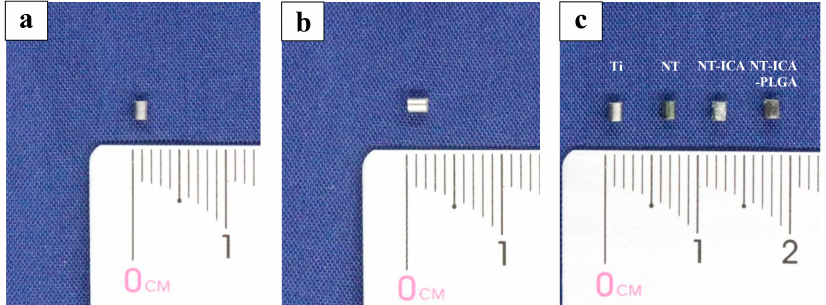
Figure 1. Images of implants: ( a ) Cylindrical pure Ti implant, 1.5 mm in diameter; ( b) Cylindrical pure, 2 mm in length; ( c ) The implants of the Ti, NT, NT-ICA and NT-ICA-PLGA